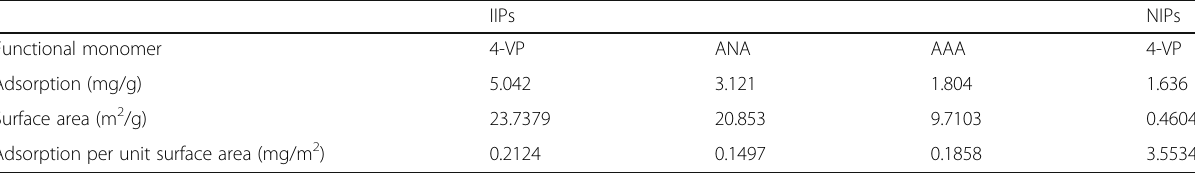
Table 1 Specific area and adsorption capacity of different materials